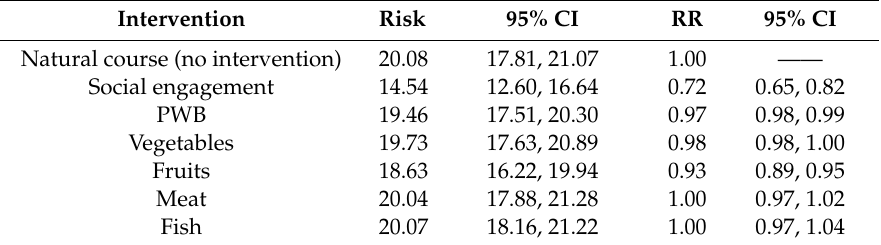
Table 2. Cognitive impairment risks under hypothetical single